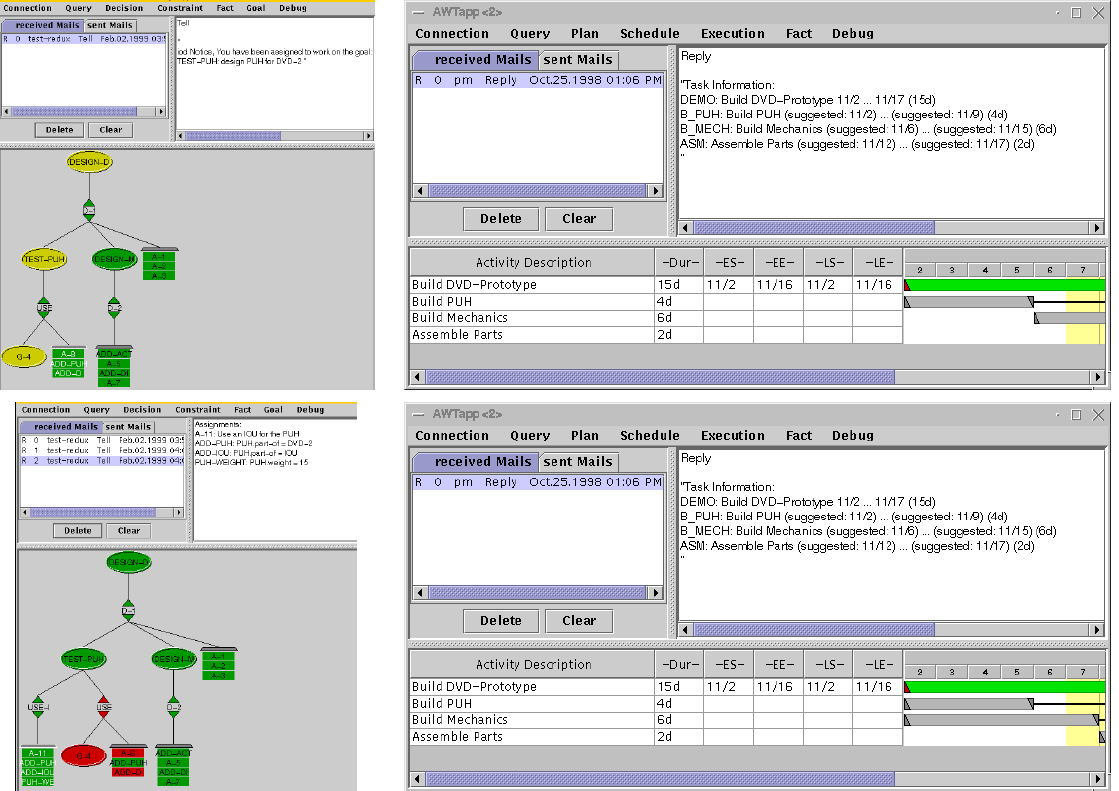
Figure 4. Design/Schedule